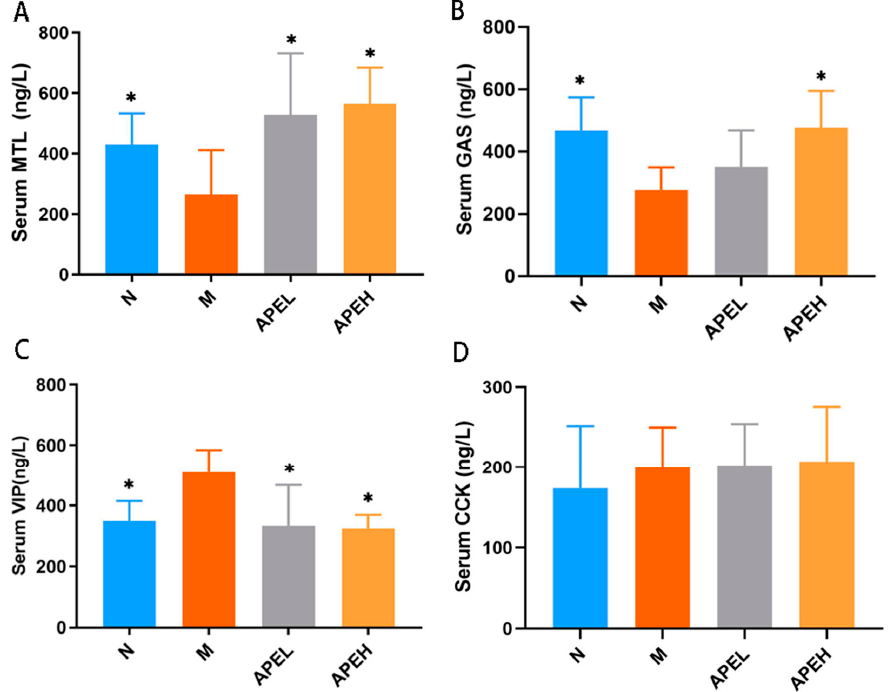
Figure 3. Effect of APE on serum gastrointestinal hormones MTL ( A ), GAS ( B ), VIP ( C ), and CCK ( D ) in FD mice ((*) p < 0.05 compared to the model group). (N, normal group; M, model group; APEL, 150 mg/kg APE group; APEH, 300 mg/kg APE group)